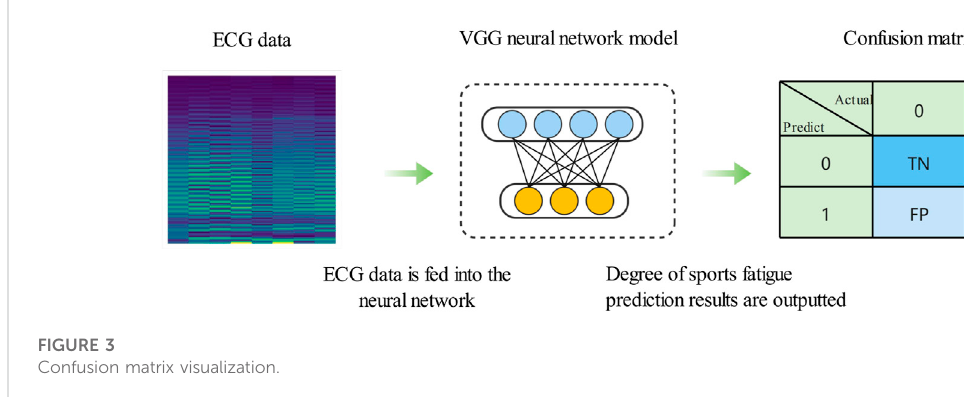
FIGURE 3 Confusion matrix